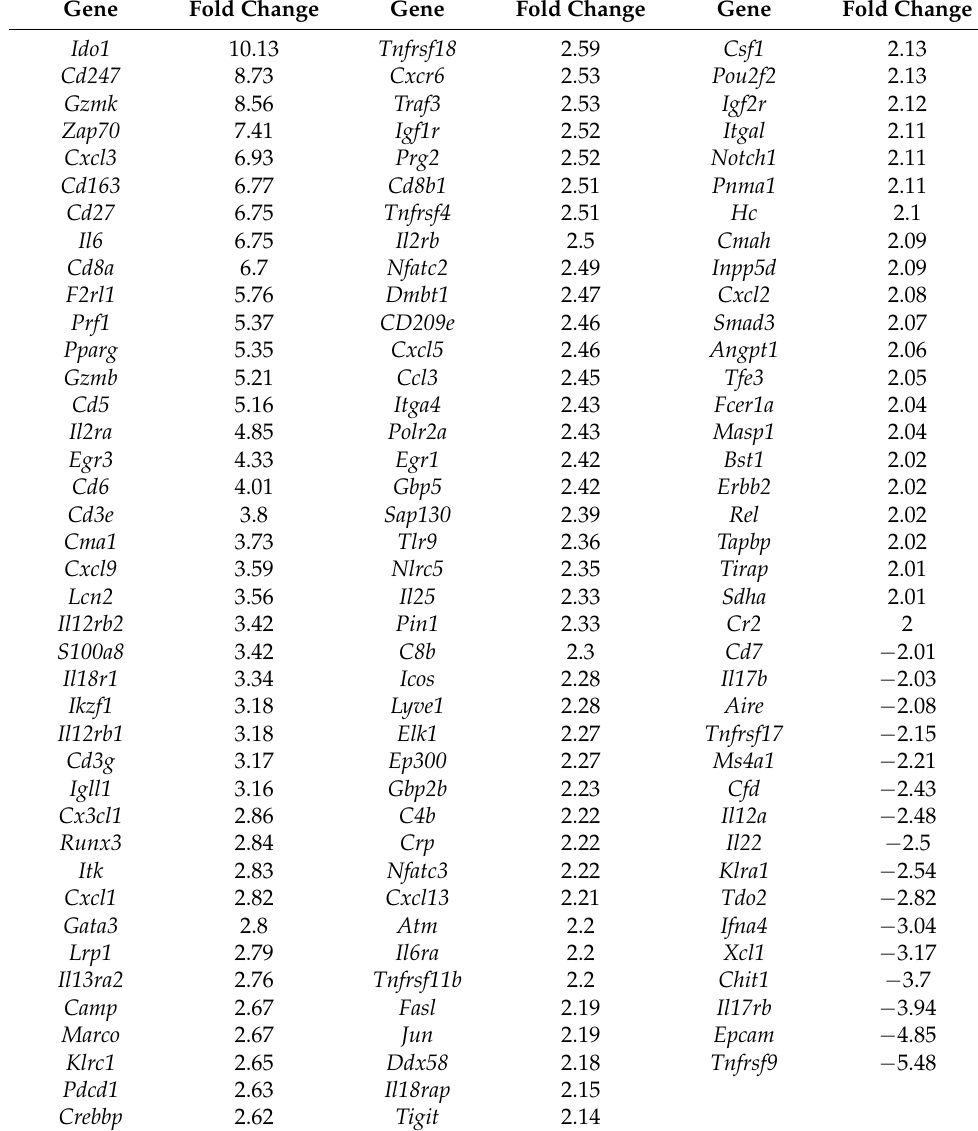
Table 1. Genes that were found to be up- or down-regulated more than 2.0-fold in Vaccine/ Bintrafusp/SX-treated mice compared to Control